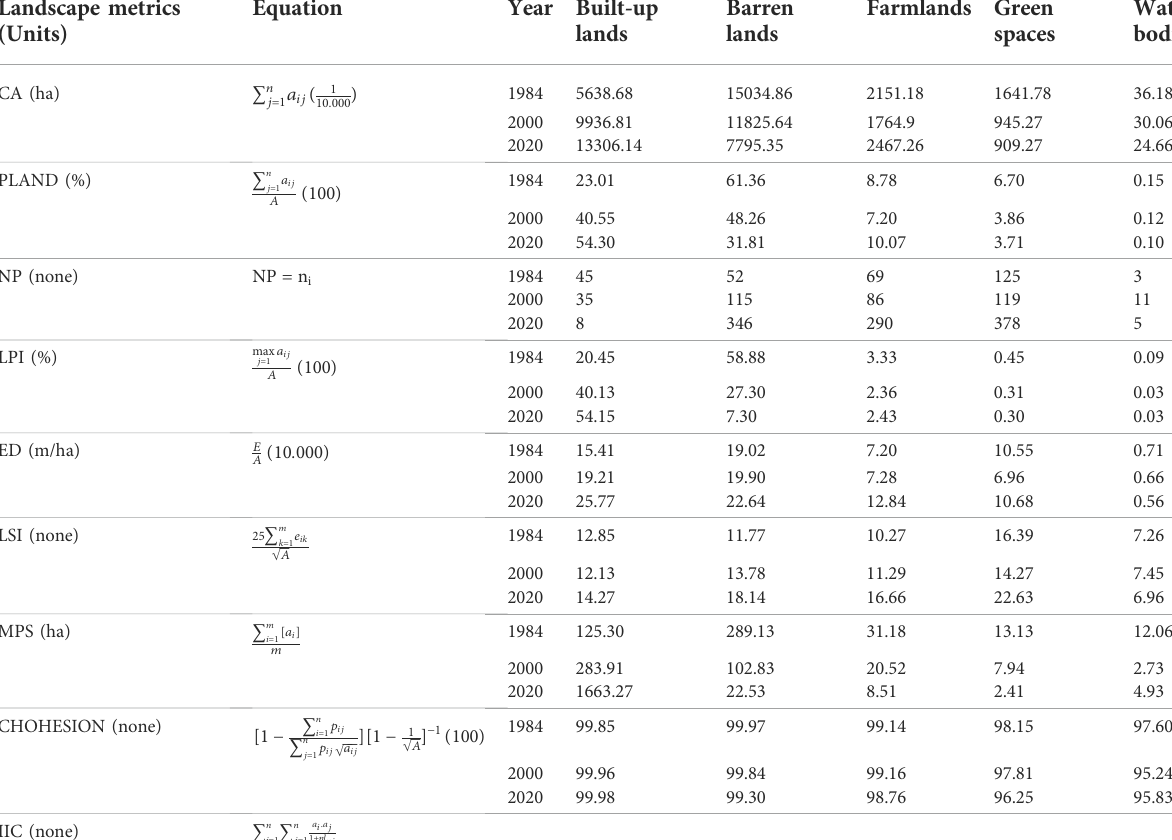
land covers (barren lands, farmlands, and green spaces) a reduction trend which indicates the convergence and fragmentation of these types of lands especially gardens and green spaces. In other words, the built-up patches have become under the upsurge of urban construction. TABLE 3 Landscape metrics and its values from 1984 to 2020 based on land uses. Landscape metrics